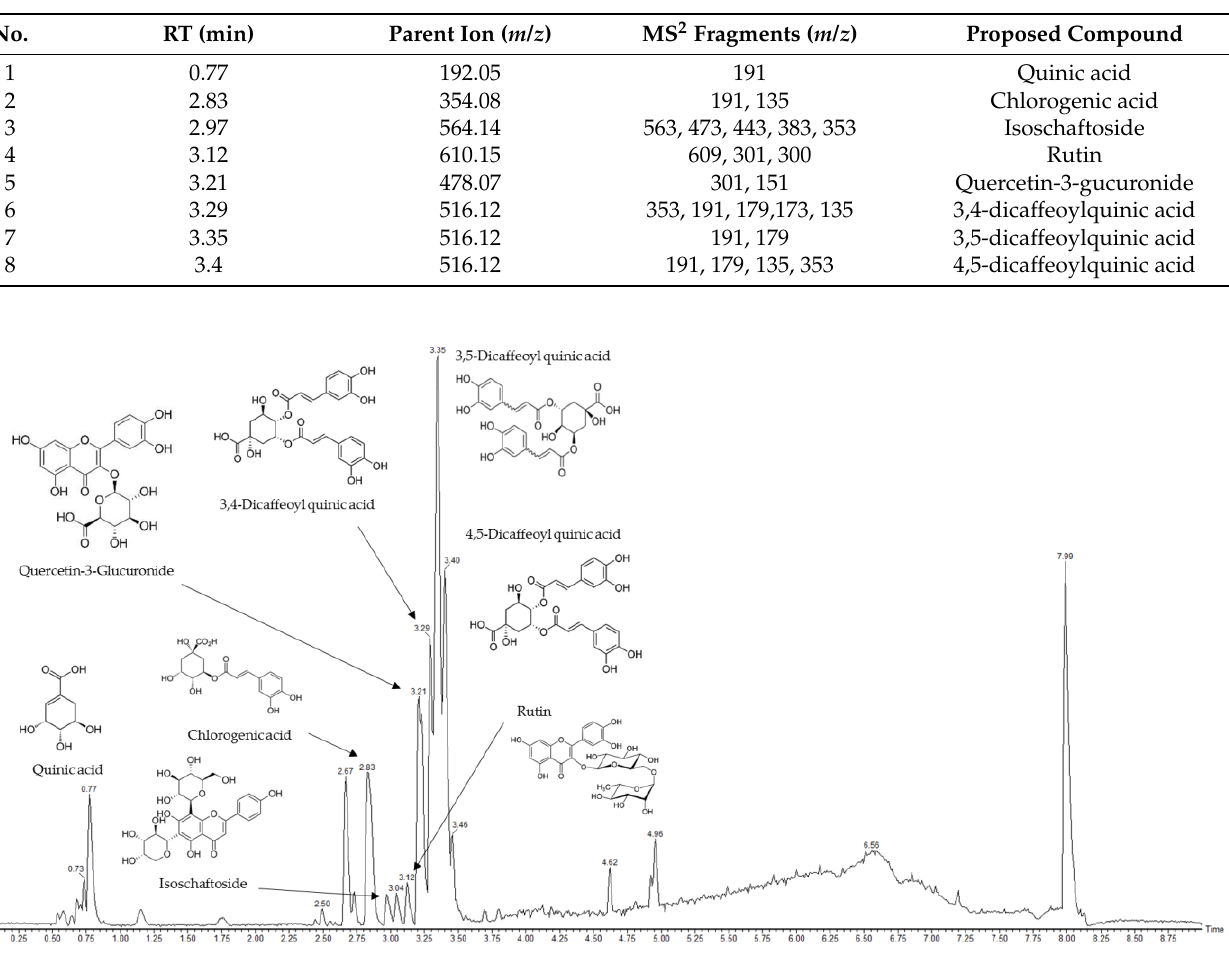
Figure 1. Analysis of AASC using UPLC/Q-TOF-MS/MS chromatography in negative ion mode. Table 1. The identified compounds in the